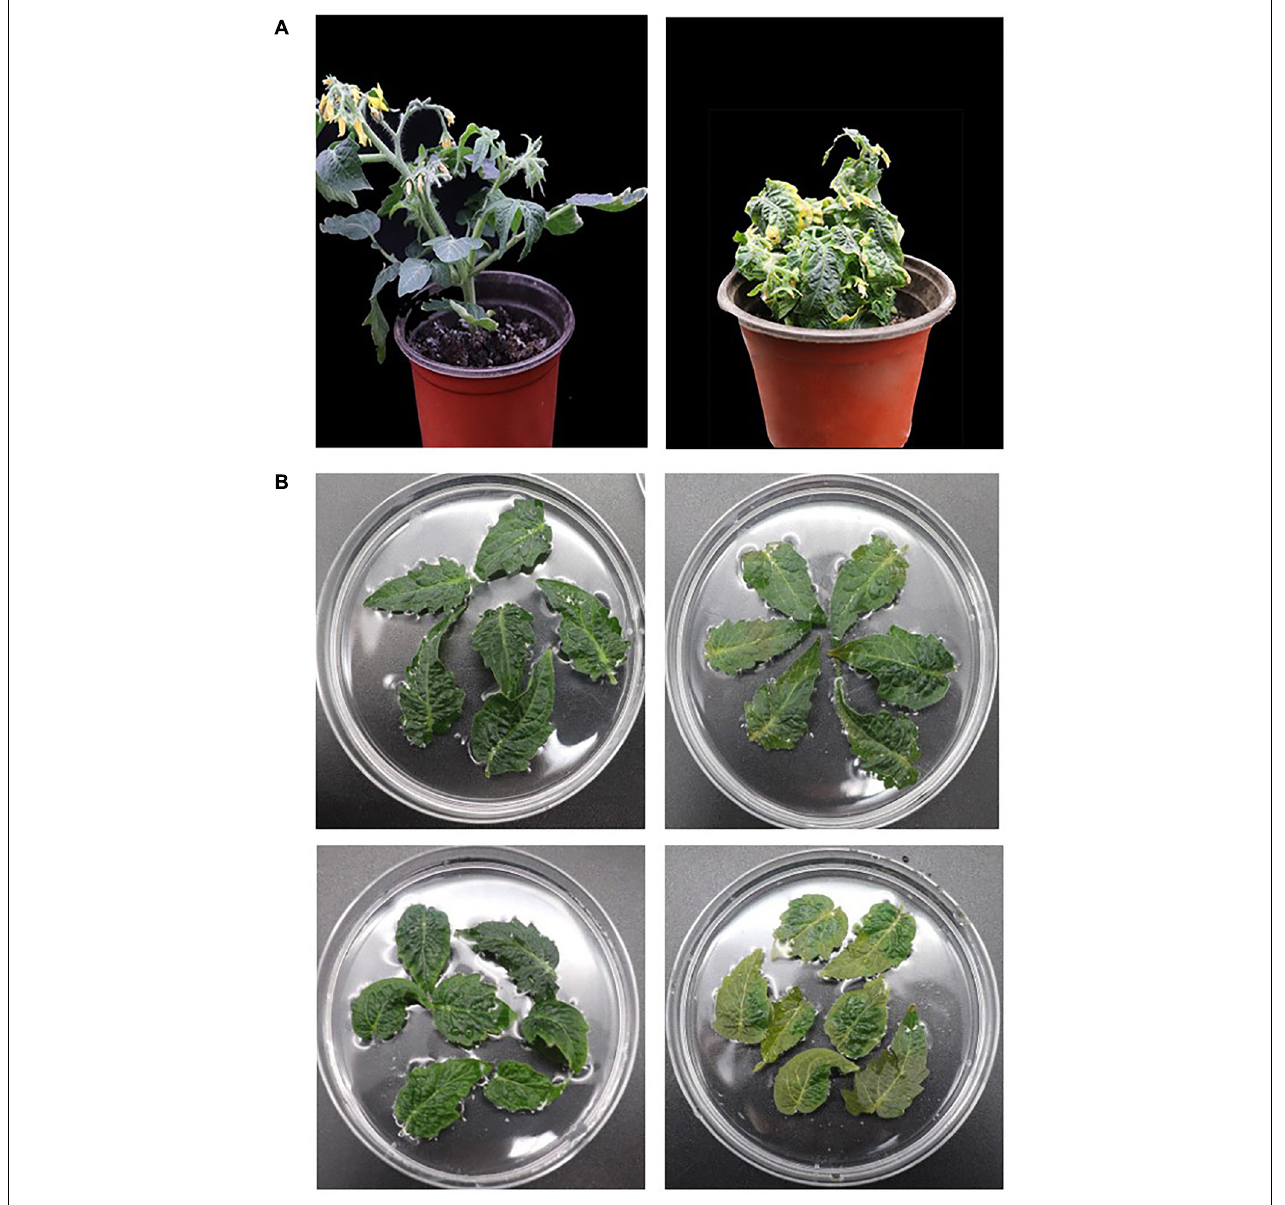
FIGURE 7 | Phenotype of the leaf senescence in SlCCX1-LIKE-OE plants. (A) The whole WT (left) and SlCCX1-LIKE-OE (right) transgenic plant. (B) Phenotypes of leaves with H 2 O 2 treatment. The detached leaves of WT (left) and SlCCX1-LIKE-OE (right) plants were treated with H 2 O 2 at 1 and 4